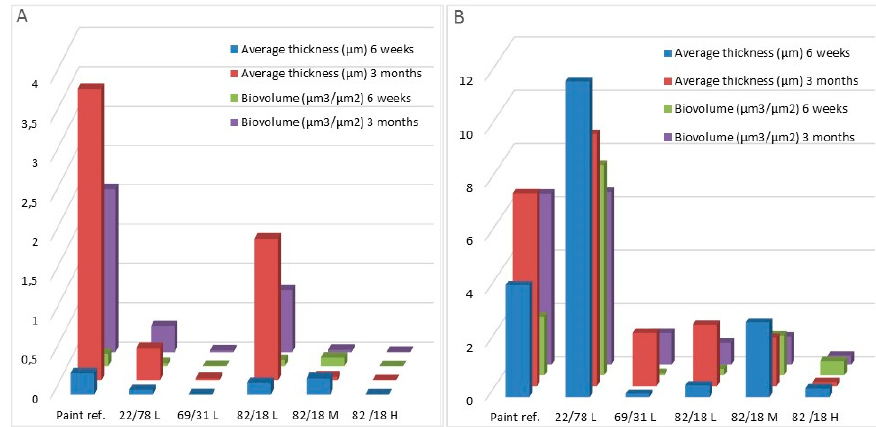
Figure 3. Quantification of: ( A ) bacteria; and ( B ) microalgae in biofilms on paints after six weeks and three months of immersion.